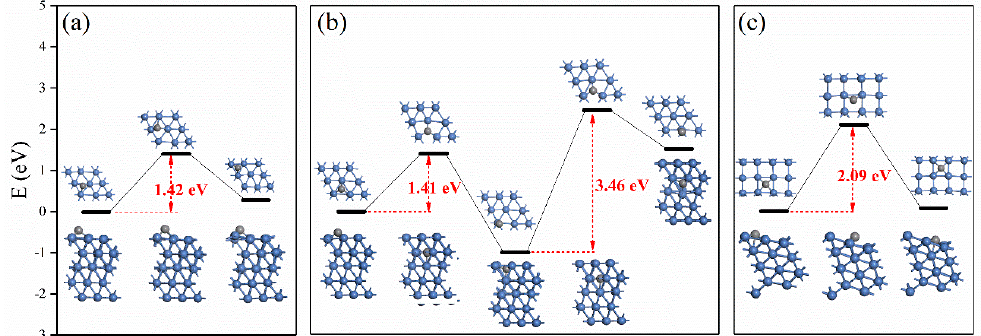
Figure 9. Potential energy diagram calculated by DFT for the C transport path of ( a ) surface diffusion on Ni (111), ( b ) bulk diffusion on Ni (111) and ( c ) surface diffusion on Ni (511) with an indication of the transport energy barrier (blue atoms denote nickel and gray atoms denote carbon.).